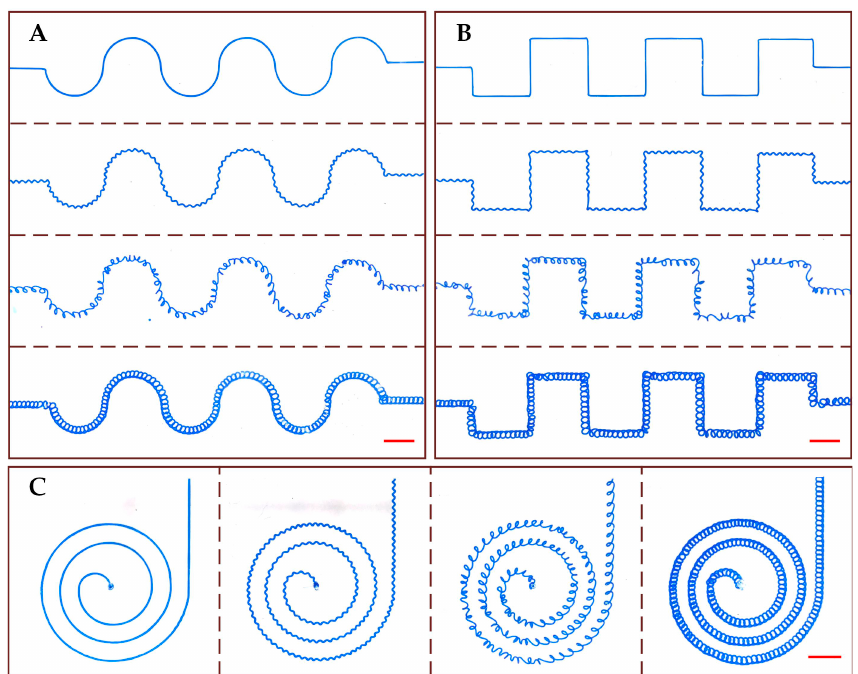
Figure 7. Optical photos of the complex microchannels with di ff erent structural features along curved serpentine path ( A ), rectangular serpentine path ( B ), and spiral path ( C ). A blue dye solution is perfused into the microchannel for visualization. The red scale bar represents 5